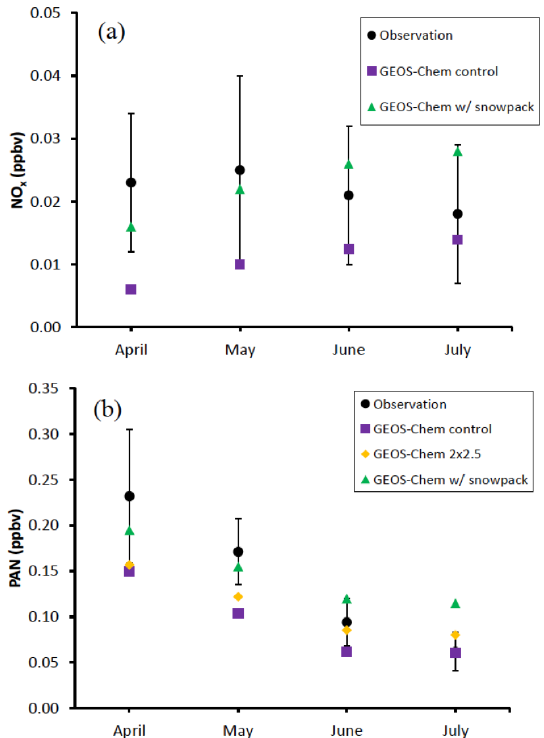
Figure 4. Monthly mean surface (a) NO x and (b) PAN mixing ra- tios from observations (black circles), simulations with (green trian- gles) and without (purple squares) snowpack emissions, and GEOS- Chem simulations with a horizontal grid resolution of 2 ◦ × 2.5 ◦ (or- ange diamonds) for April–July during July 2008–June 2010. Verti- cal bars denote standard deviations over the course of observations for each